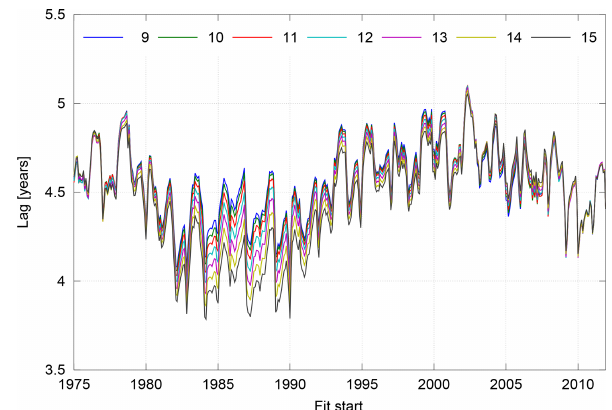
Figure 13. Lag time τ for fit interval length 9 to 15 years calculated for the SF 6 time series at 20hPa and 40 ◦